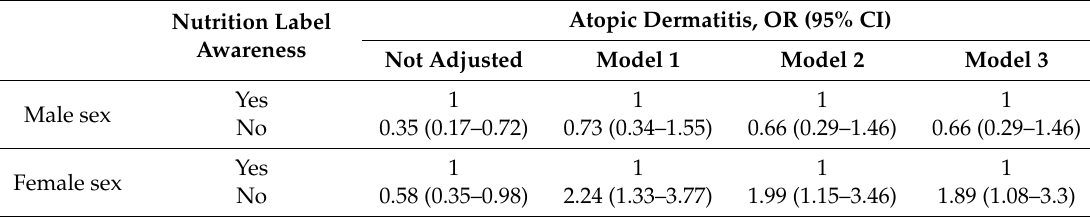
Table 3. Association between nutrition label awareness and atopic dermatitis according to sex. Nutrition